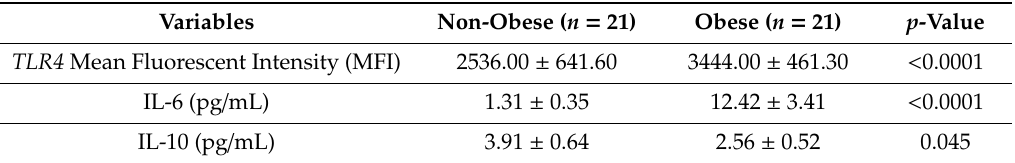
Table 3. The cell surface expression of monocytes TLR4 expressed as mean fluorescent intensity (MFI), IL-6 and IL-10, in non-obese versus obese